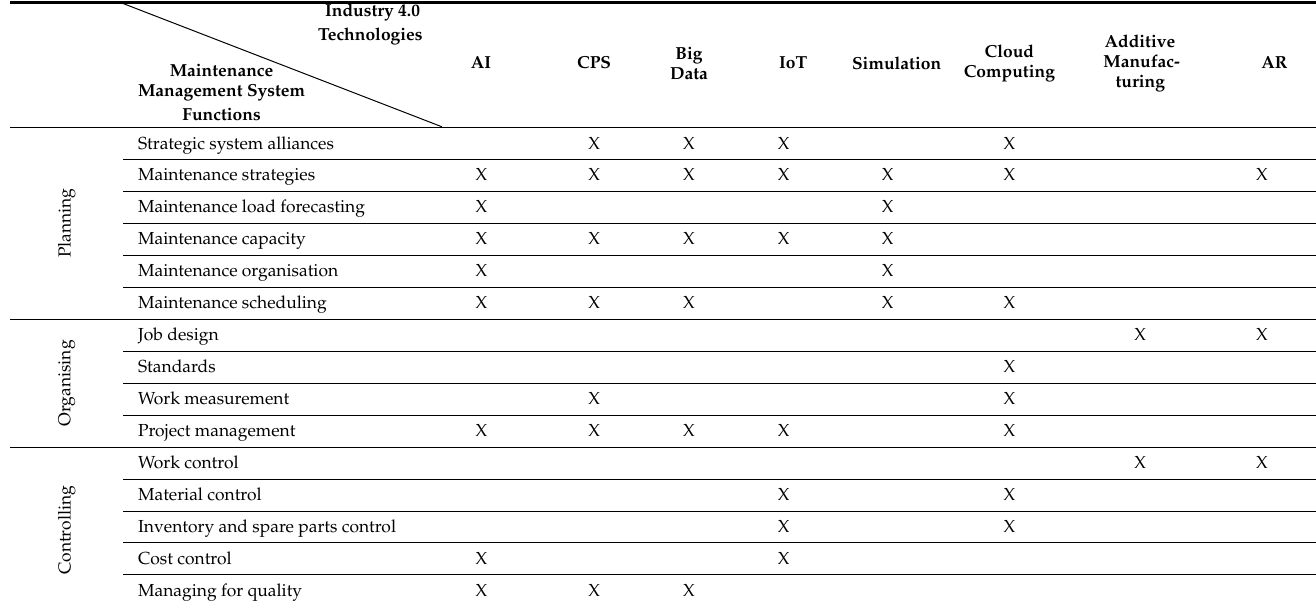
Table 4. Relationships between Industry 4.0 technologies and maintenance management system functions. Source: Authors’